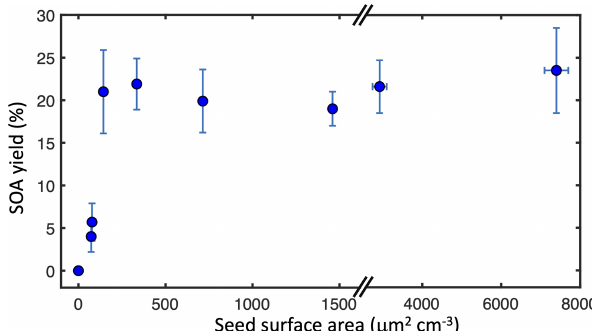
Figure 7. Measured ozonolysis-corrected SOA yields from seed area experiments (17–25) plotted against initial seed surface area. Error bars denote experimental uncertainty from SMPS measure-